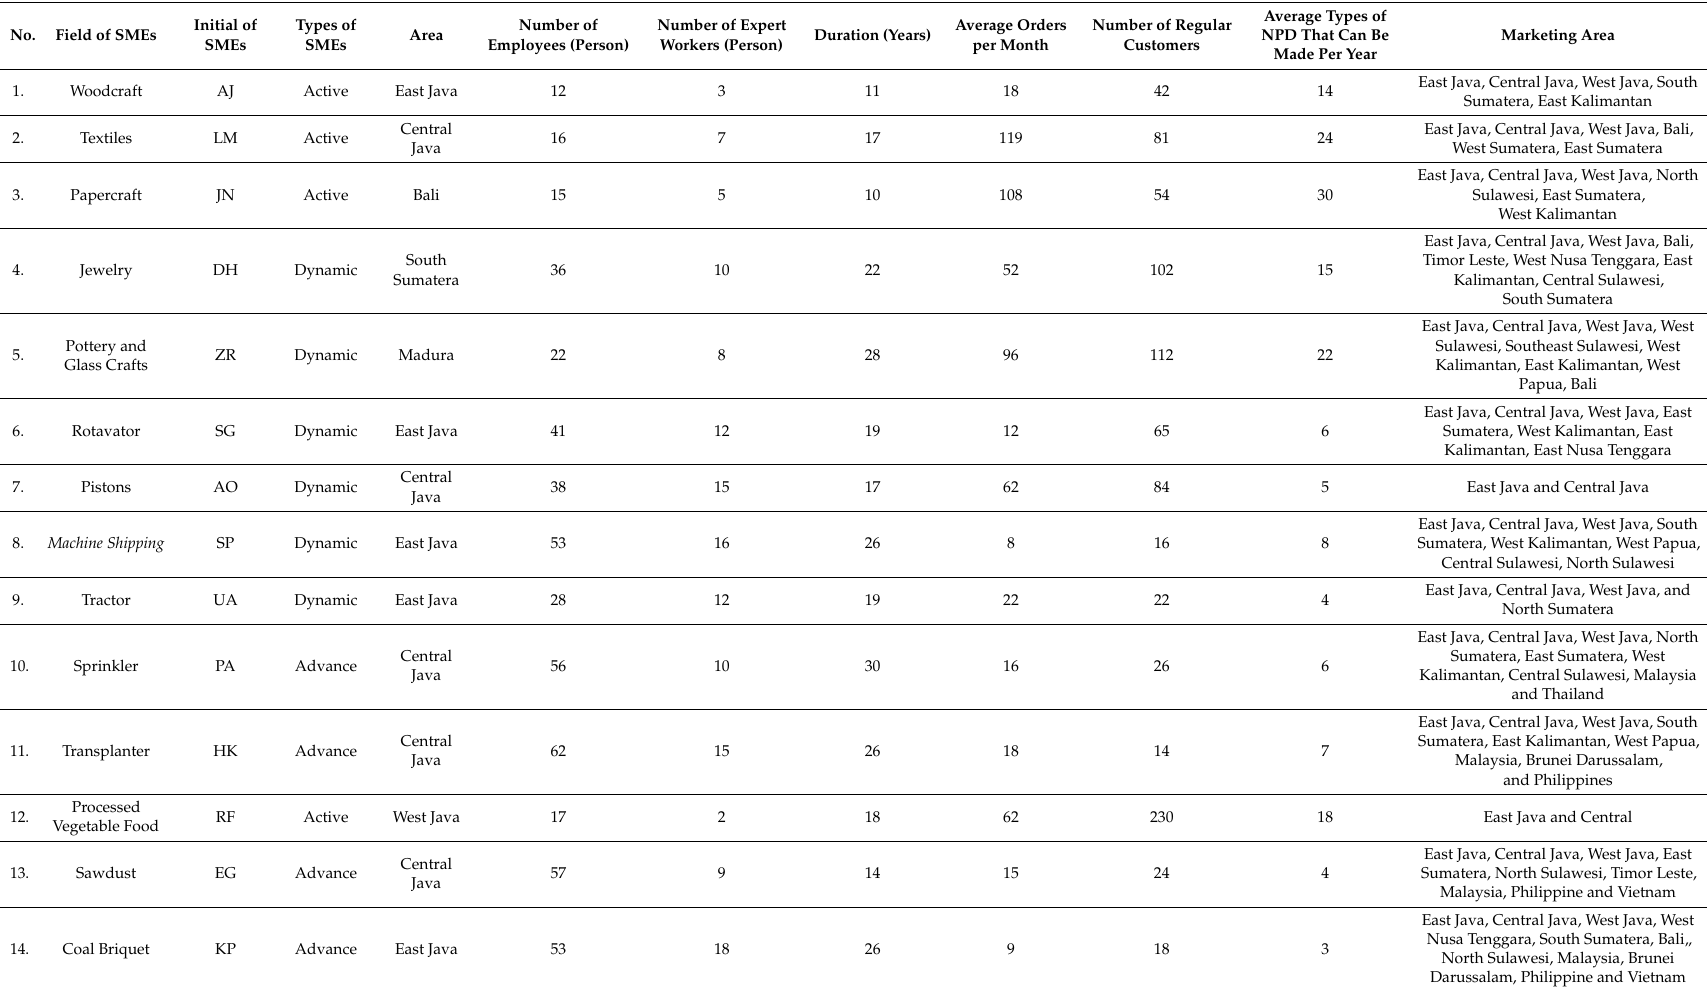
Table 3. The characteristics of research